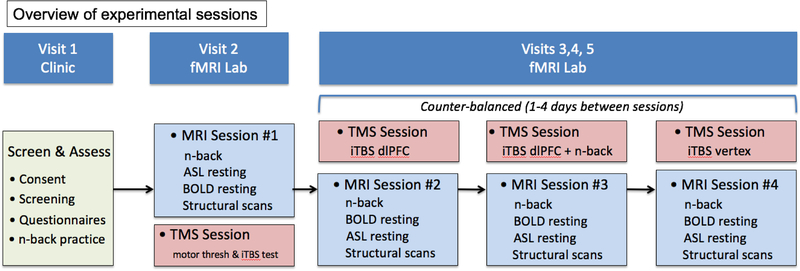
Experimental design.